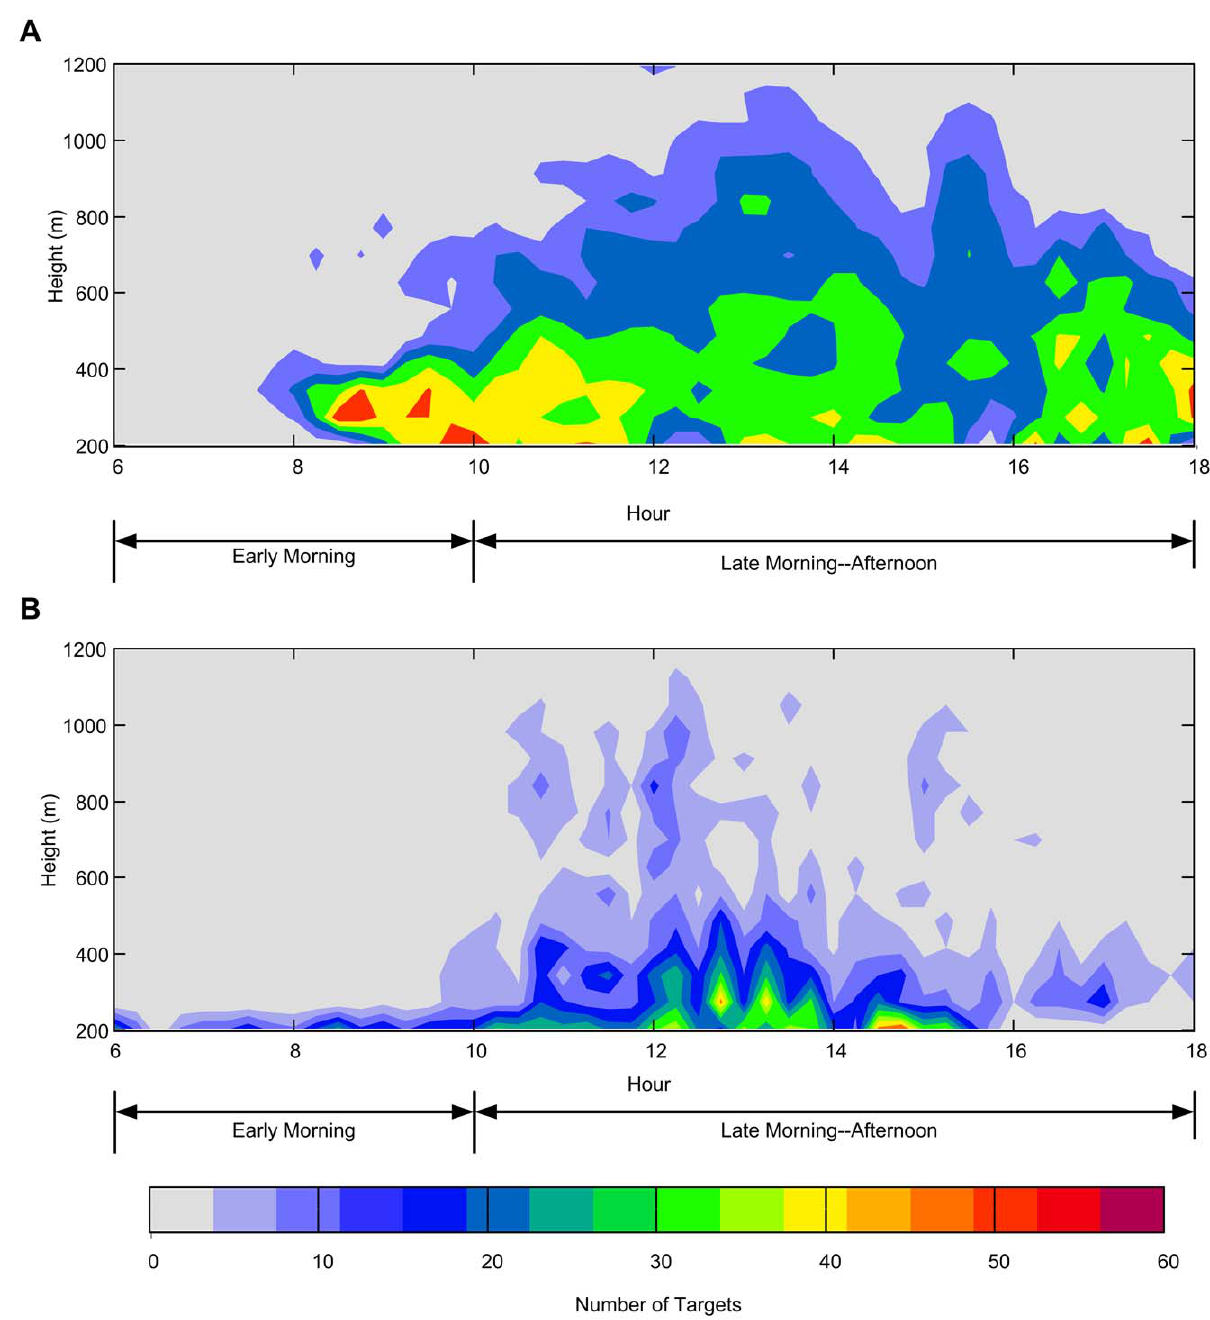
Figure 2. Time/height plots for numbers of insects recorded by a VLR at Cholbolton, Hampshire, UK. The colour scale bar refers to the number of individually-resolvable insects detected by the radar at each sampling height in each 5-minute period. The X-axis shows time of day (GMT), and the ‘early’ and ‘late’ analysis periods are indicated. A. Insect densities on a warm day (05 September 2004), when air temperatures at 10 m, 150 m and 600 m were 24.7 u C, 22.8 u C and 18.5 u C respectively. B. Insect densities on a much cooler day (15 September 2004), when air temperatures at 10 m, 150 m and 600 m were 15.4 u C, 13.2 u C and 8.8 u C respectively. Substantial density was constrained to time-periods and altitudes where air temperatures were relatively warm. Air temperatures were obtained from the UK Met Office’s ‘Unified Model’ [14]. doi:10.1371/journal.pone.0054202.g002 density ( D ) responses in the regression models or to parameters (i.e G , S, r and mean) in data exploration section.